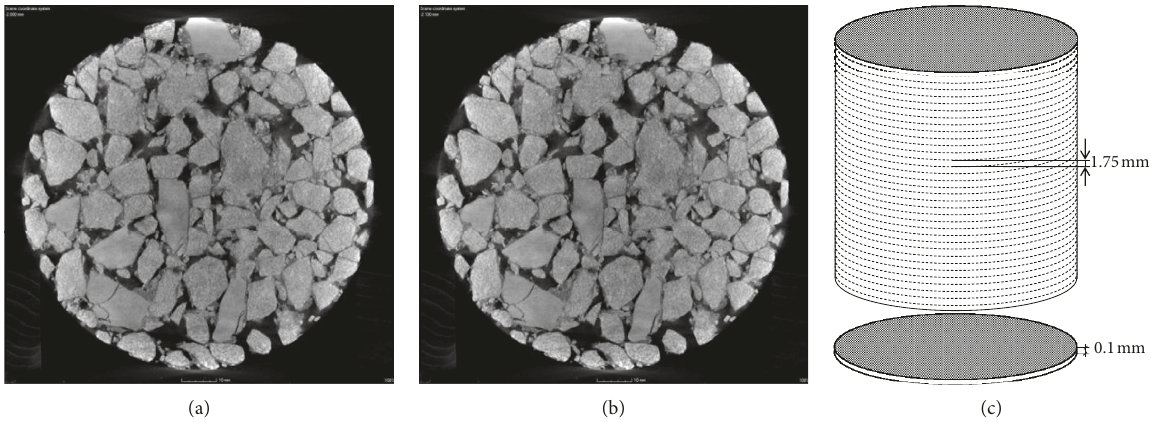
Figure 3: The assumption for this study: (a) X-ray CT image of PAC-16(A) specimen at 2.0mm height, (b) X-ray CT image of PAC-16(A) specimen at 2.1 mm height, and (c) schematic